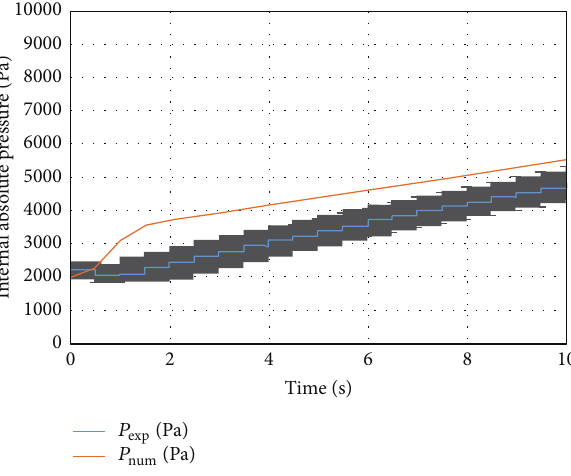
Figure 5: Pressurization of the chamber in the first 10s.